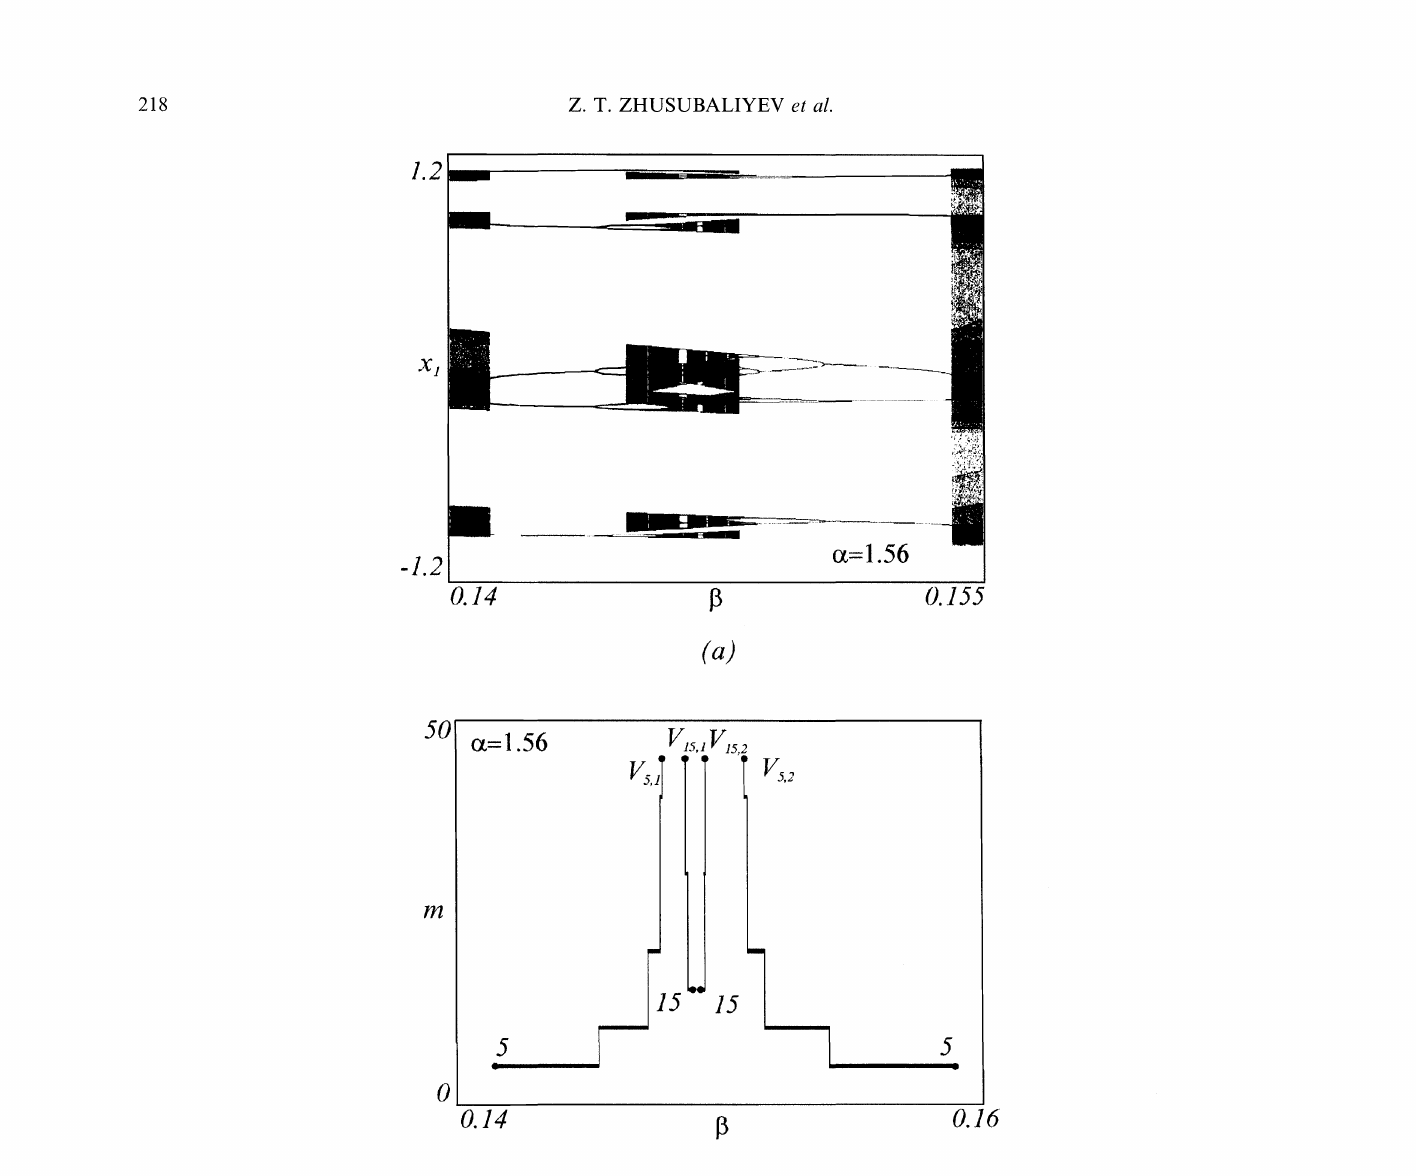
FIGURE 16 (a) Bifurcation diagram for a 1.56 and 0.14 _</3 _< 0.155 and (b) branching pattern for a 1.56 and 0.14 _</3 _< 0.16. This section intersects that region of the domain II5 swallw where two stable periodic, stable periodic and chaotic or two chaotic motions can